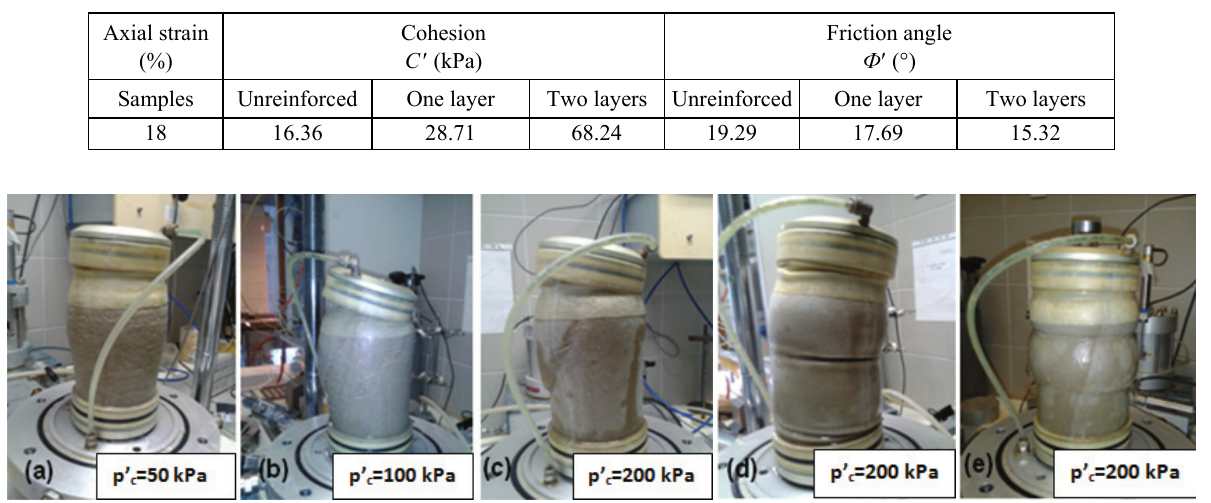
Fig. 12. Photographs of specimens after shearing: (a), (b) and (c) unreinforced specimens, (d) one layer reinforced specimen, and (e) two layer reinforced